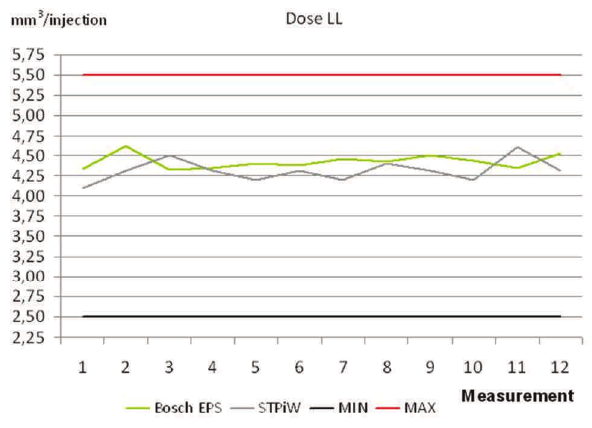
Fig. 8. LL test (actuation time 600 µs, pressure 25